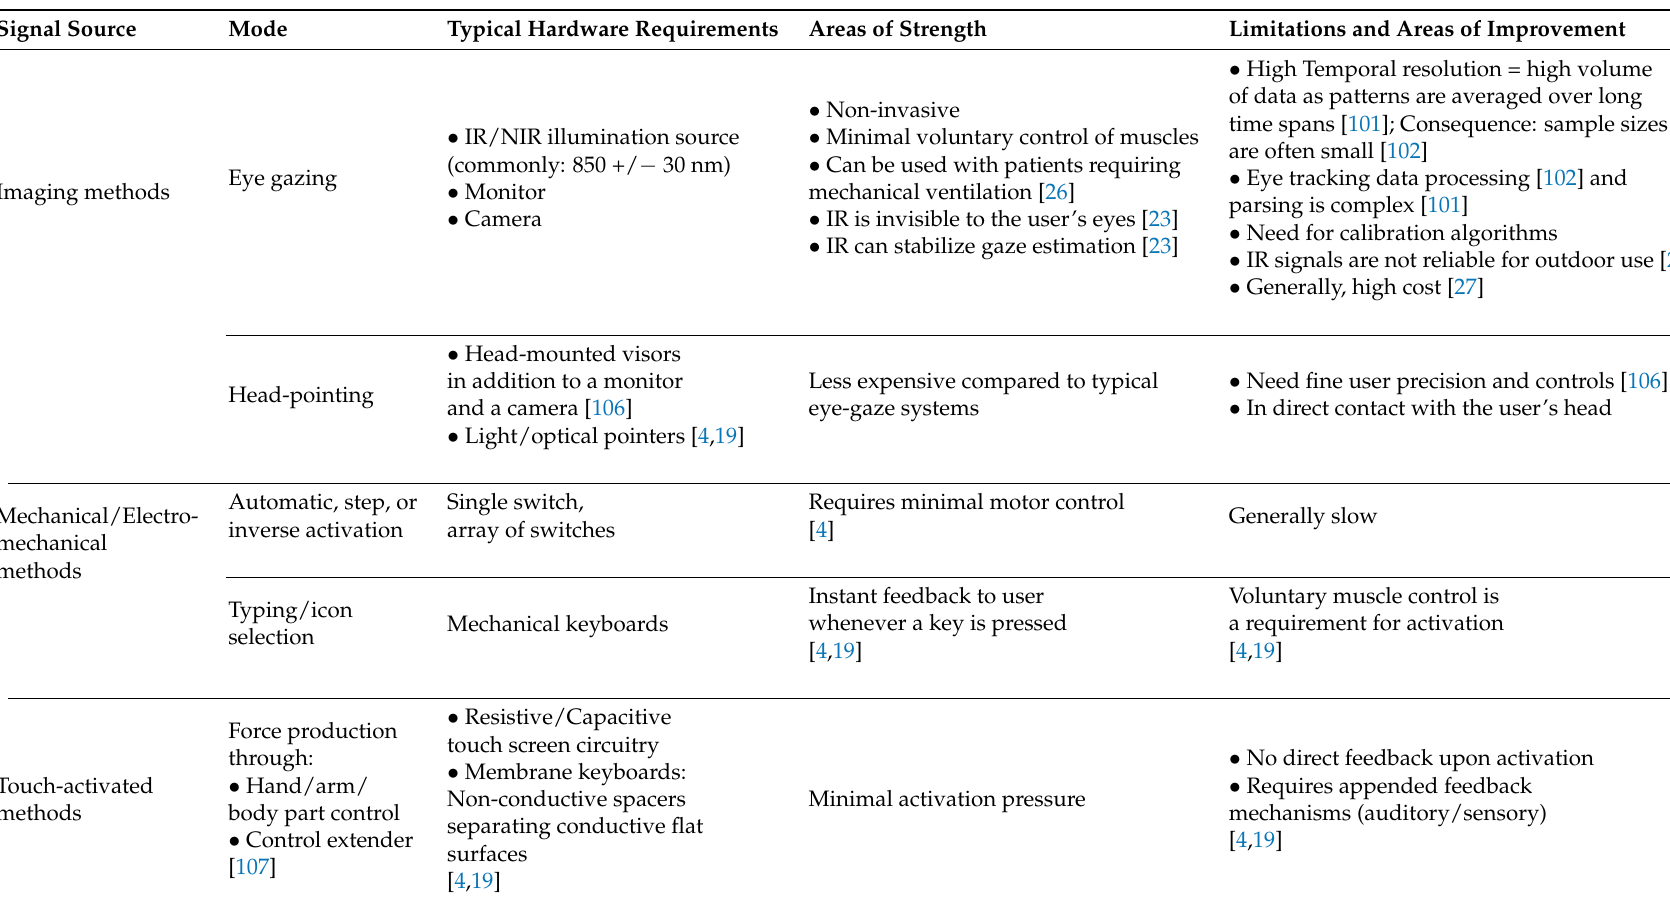
Table 2. Signal sources, areas of strength and areas of limitation of current commercial AAC